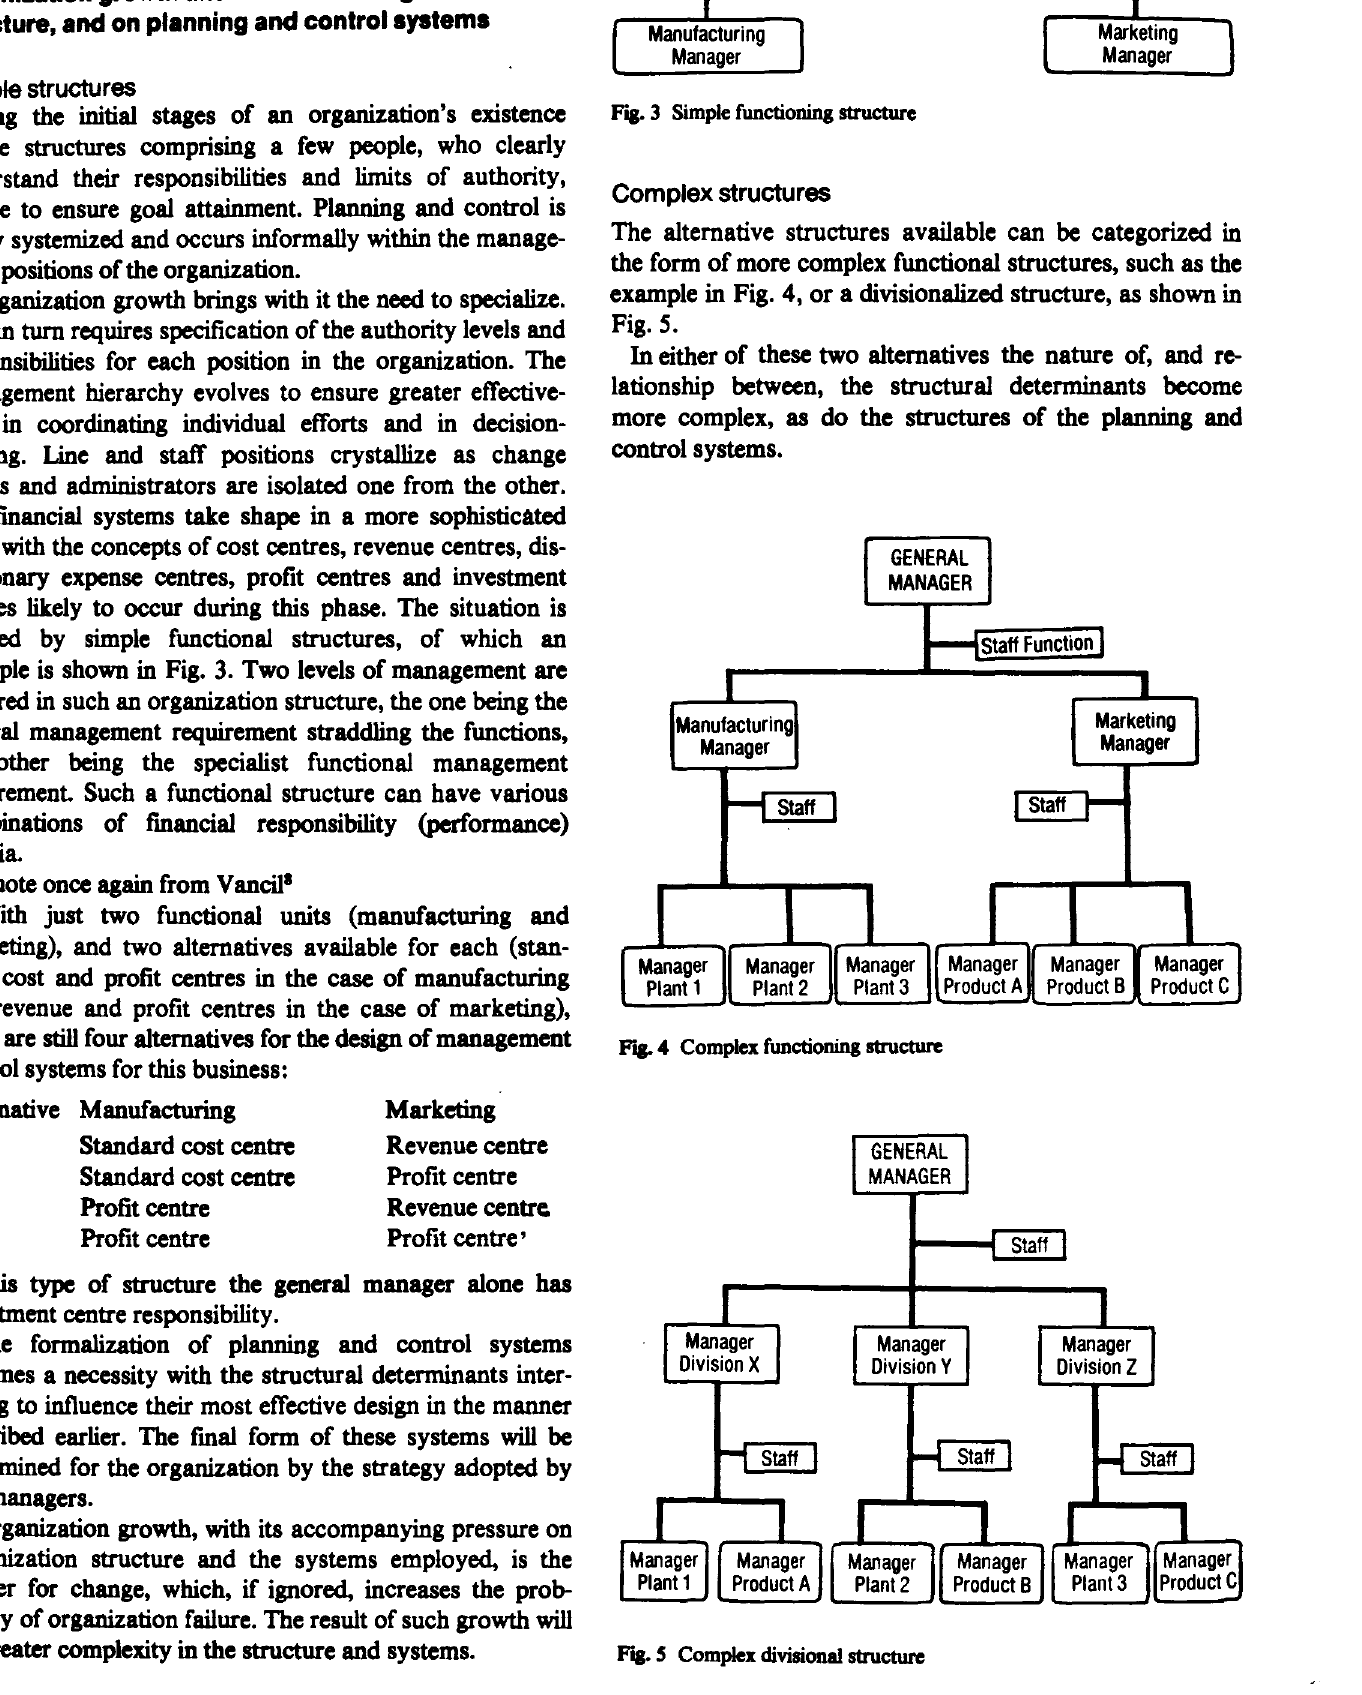
Fig. 3 Simple functioning structure